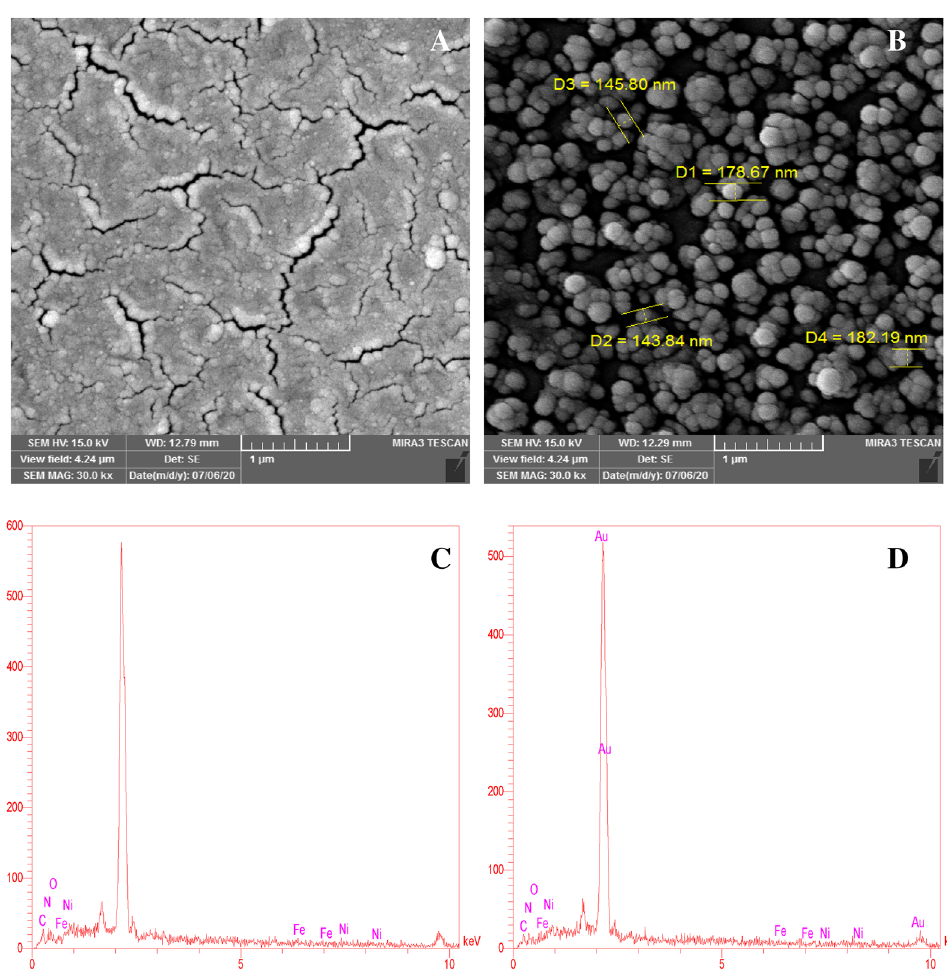
Figure 2. SEM images of NiFe-LDH/rGO nanocomposites ( A ); NiFe-LDH/rGO/AuNPs nanocomposites ( B ); EDS spectra of NiFe-LDH/rGO ( C ) and NiFe-LDH/rGO/AuNPs (D) on the